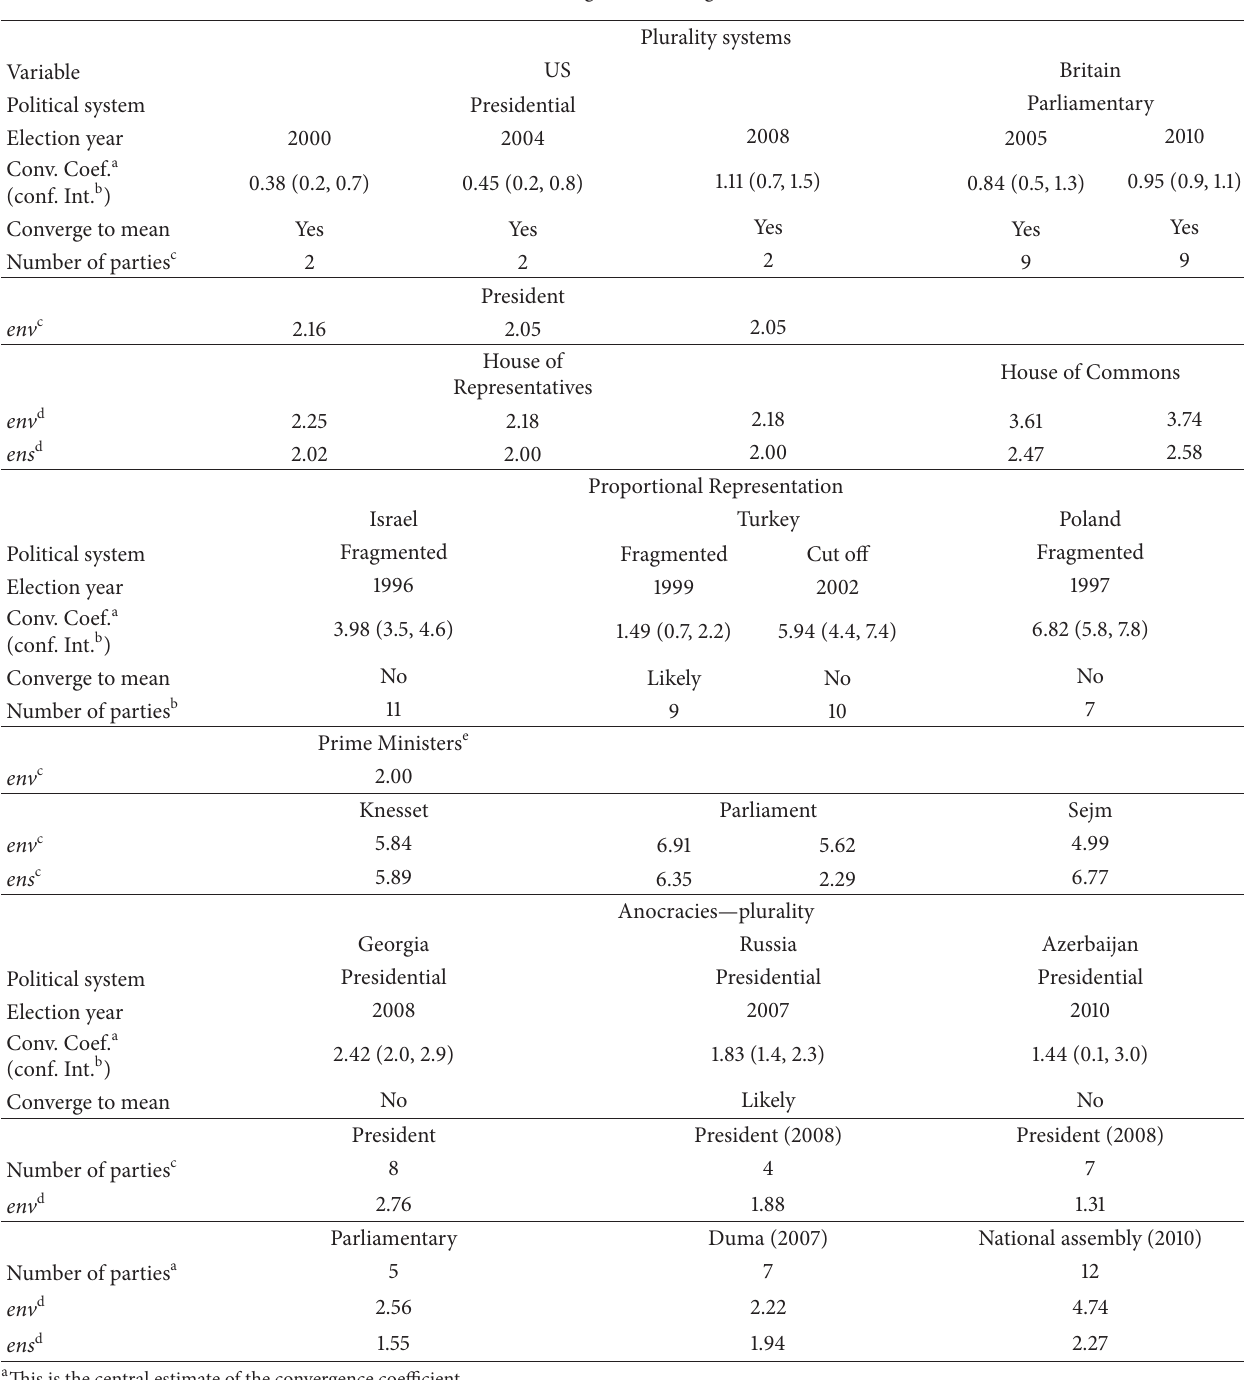
Table 7: Convergence and